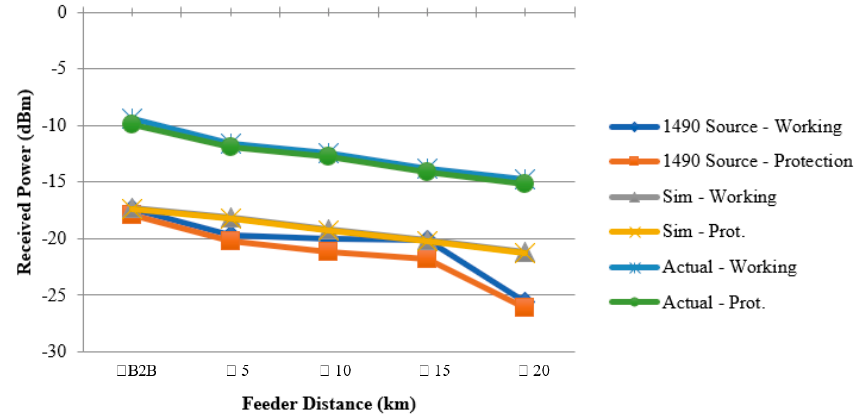
Figure 17. Effect of varying feeder distance to the received optical power.